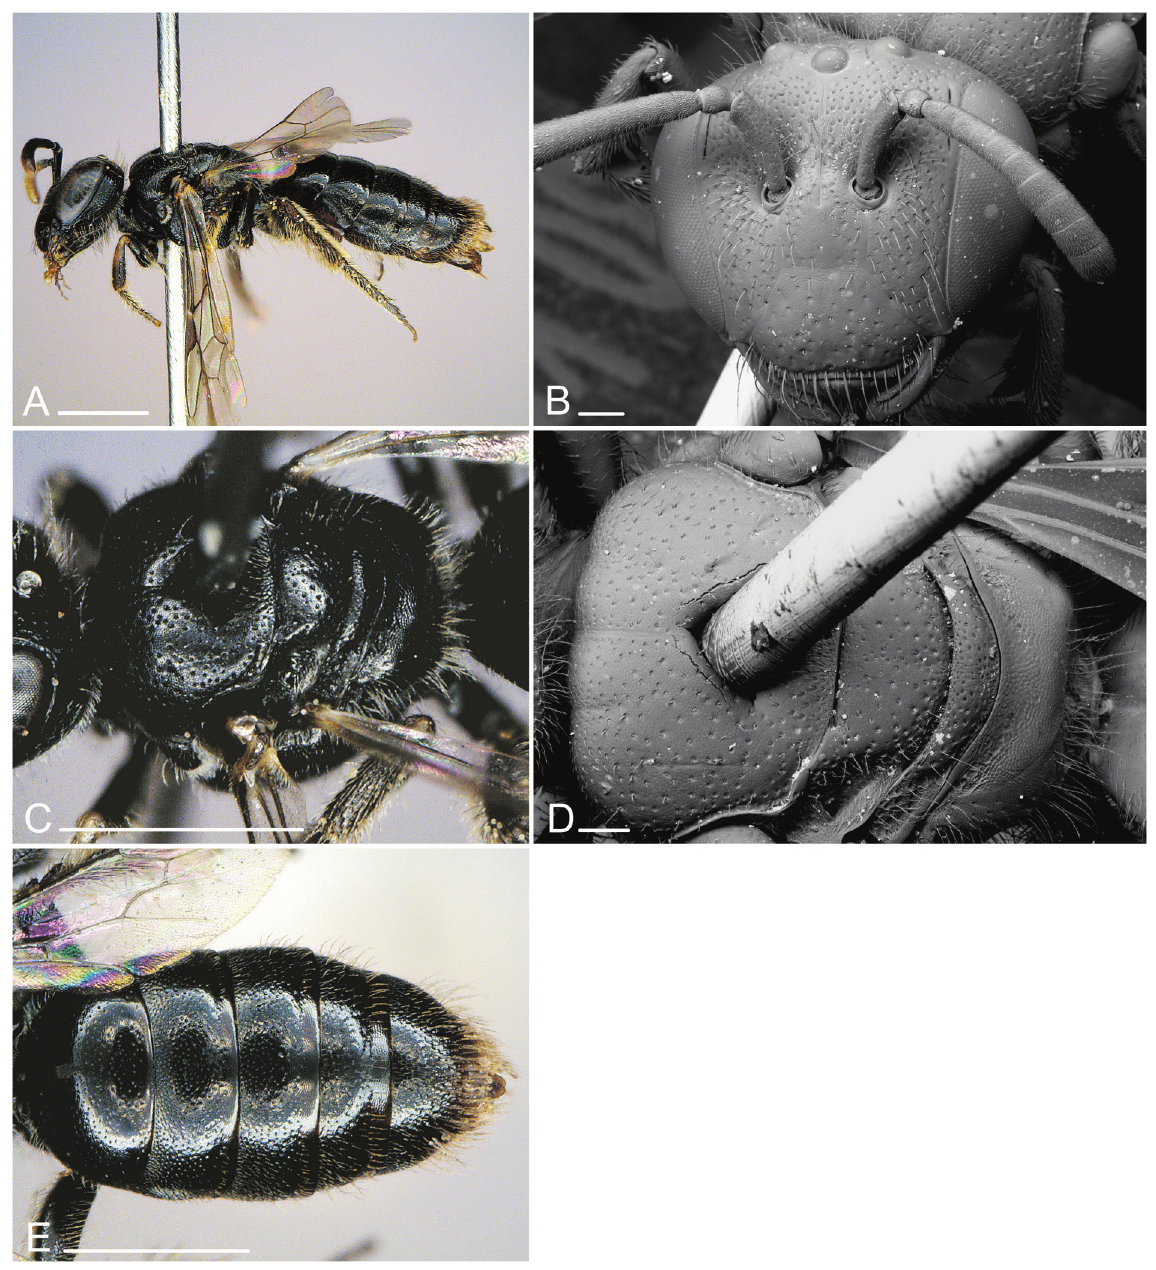
Fig. 15. Scrapter minutus sp. nov., ♀. A . Lateral view. B . Head (SEM). C . Thorax (dorsal view). D . Thorax (dorsal view, SEM). E . Metasoma (dorsal view). Scale bars: photos: 1 mm, SEM: 0.1